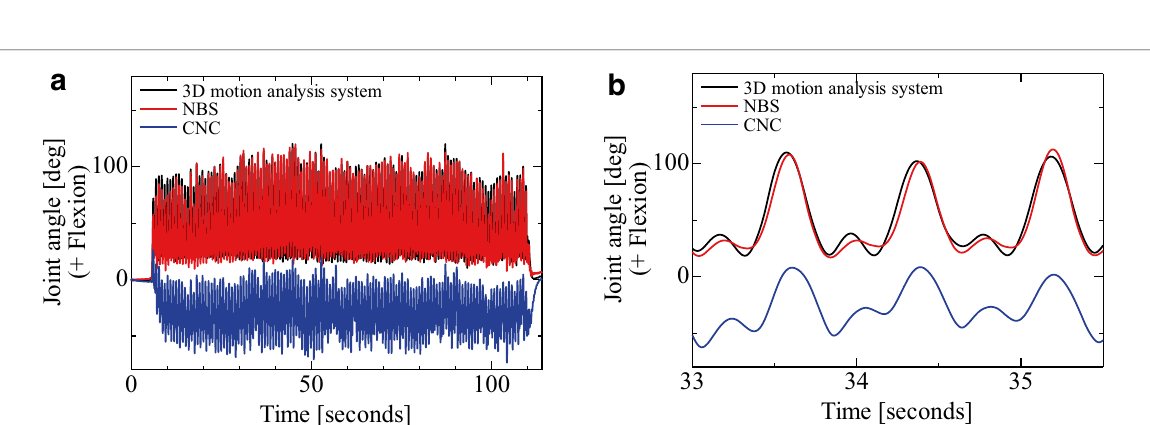
in Fig. 4(a) changes periodically between 25° over the entire measurement time, which is gener- ally consistent with results obtained using the optical 3D